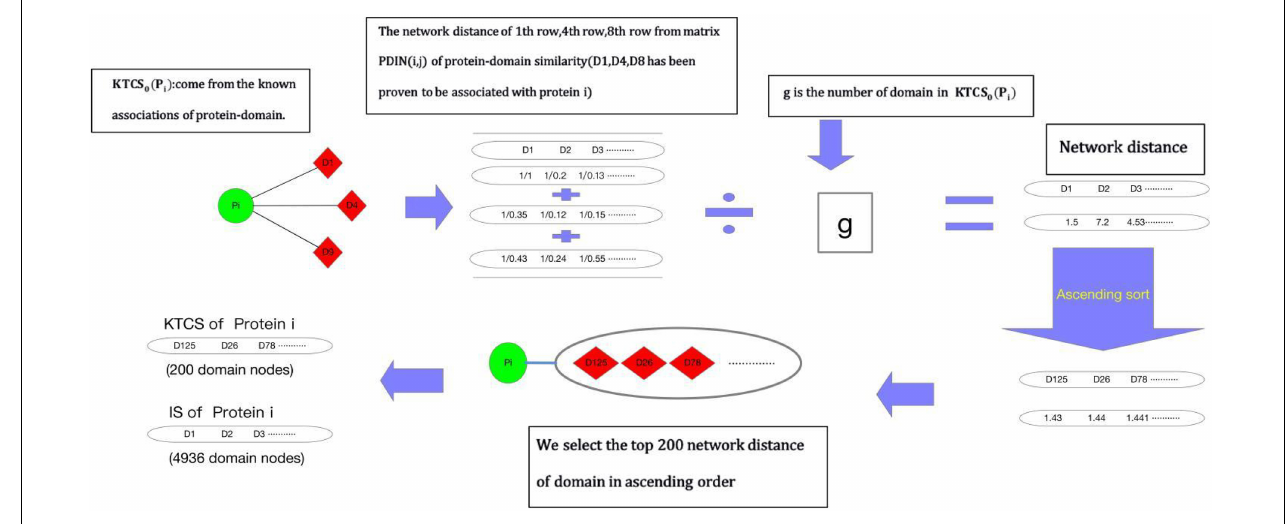
FIGURE 1 | Flow chart of constructing KTCS for any given protein node p i in